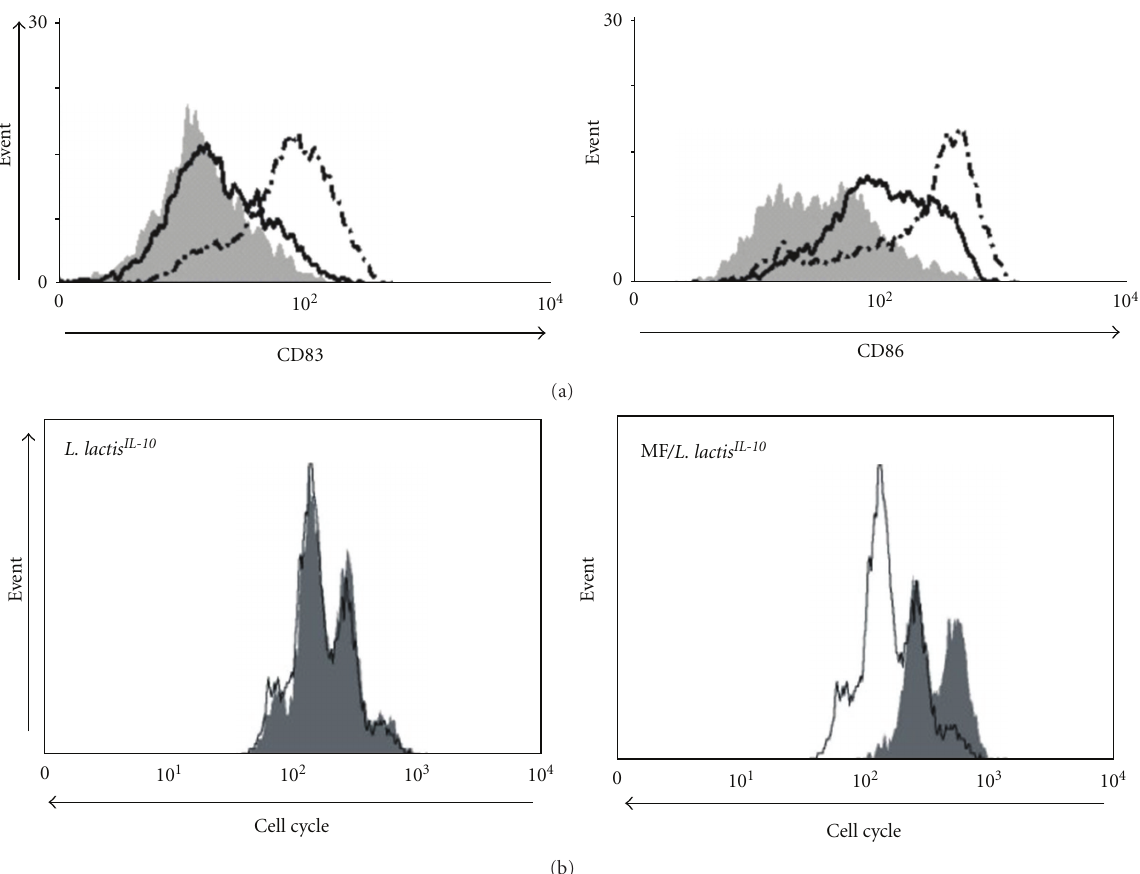
Figure 2: (a) Immature DCs were not matured (grey histogram), matured with 1 × 10 5 cfu viable L. lactis IL - 10 (continuous line), or matured with MF and 1 × 10 5 cfu viable L. lactis IL - 10 (dotted line). CD83 (left panel) and CD86 (right panel) expression was assessed after 48 hours by flow cytometry. (b) Immature DCs were primed with MF or 1 × 10 5 cfu viable L. lactis IL - 10 with and without MF. Depicted is the cell cycle progression of allogenic Th-cells co-cultured with e ff ector Th-cells derived from MF-matured DC is regarded as 100% (white histograms, reference condition) and the cell cycle progression of allogenic Th-cells cocultured with e ff ector Th-cells derived from L. lactis IL - 10 (left panel) or L. lactis IL - 10 /MF-(right panel) matured DC (gray histograms).